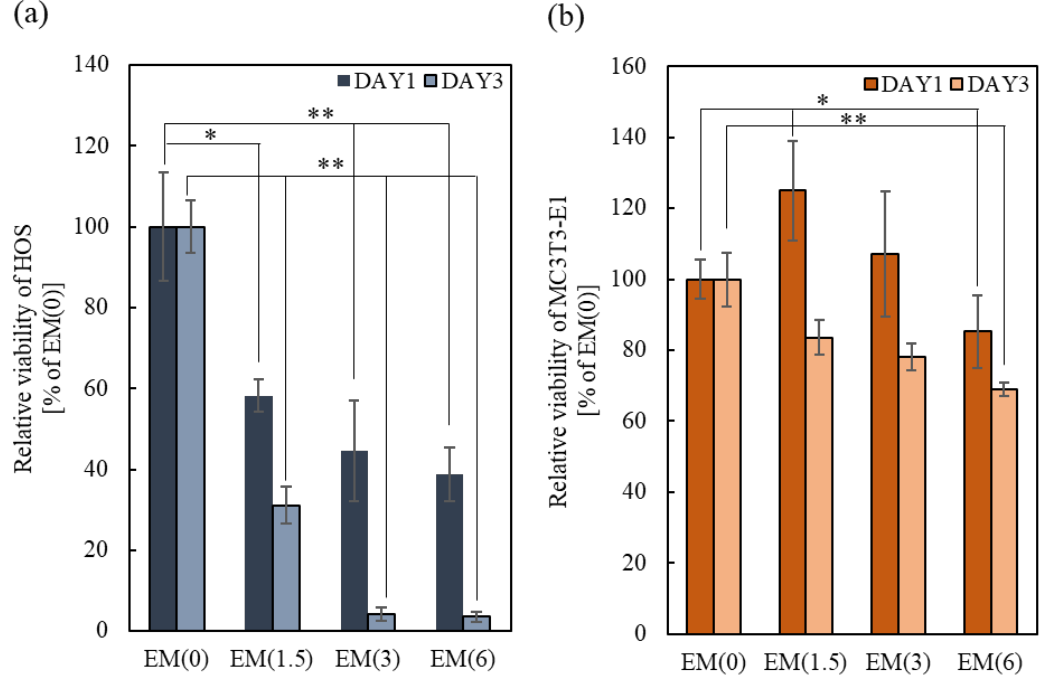
Figure 5. Effect of free-ZOL on cell viability of tumor cells and osteoblasts. HOS and MC3T3-E1were cultured in each elution medium of ZOL/β-TCP for 3 days. After culturing, relative viability of ( a ) HOS and ( b ) MC3T3-E1 were determined by 3-(4, 5-Dimethylthiazol-2-yl)-2,5-diphenyltetrazoloum bromide (MTT) assay. Error bars indicate standard deviation of the mean. The asterisks show * p < 0.05 and ** p < 0.01 as compared with EM(0) by Student’s t -test.